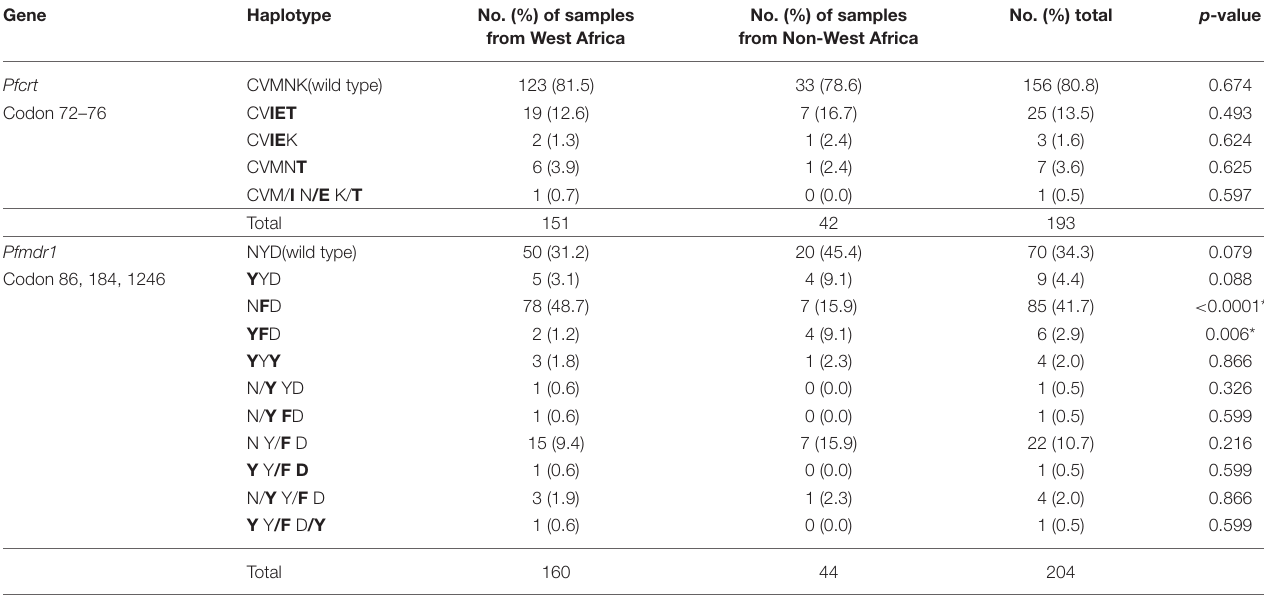
TABLE 4 | Distribution of Pfcrt and Pfmdr1 haplotypes from studied isolates. Gene